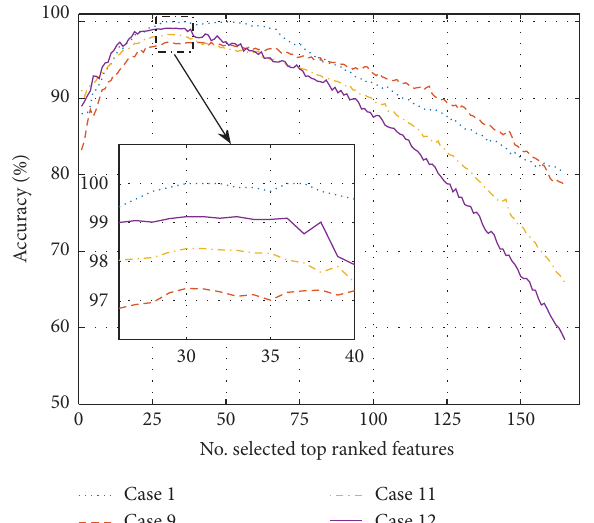
Figure 9: Classifer’s performance on the diferent number of selected top-ranked features. Te number of selected top-ranked features obtained using ANOVA is shown on the x -axis. Table 5: Comparison of classifcation accuracy, sensitivity, and specifcity by using diferent feature dimensions (mean +standard division). # of